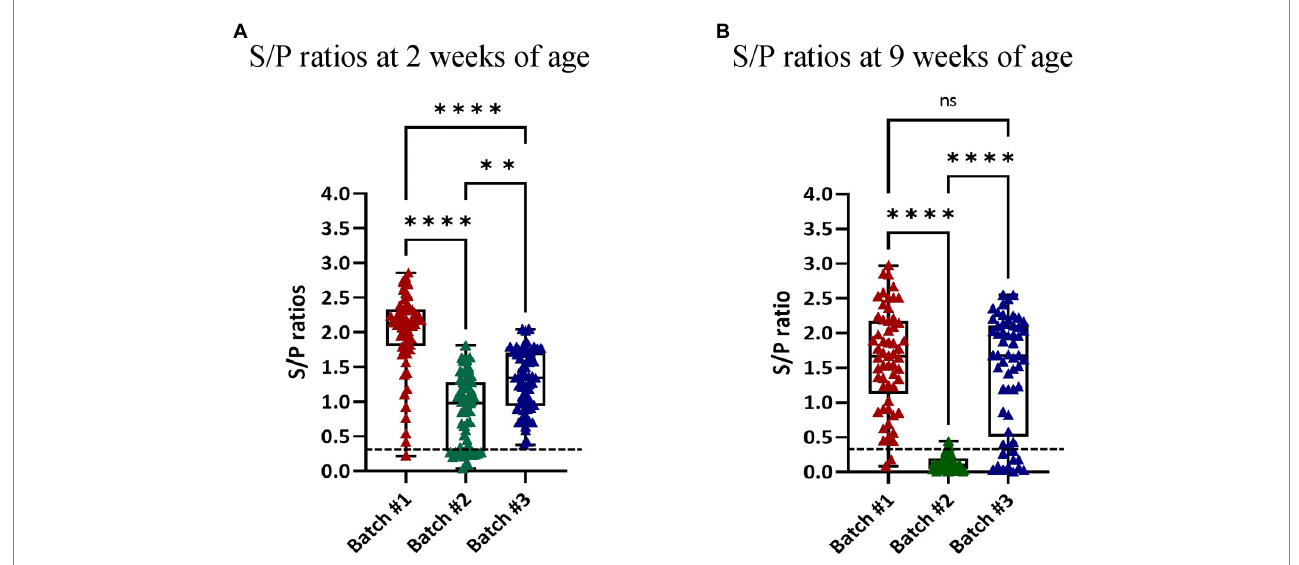
FIGURE 5 S/P ratios of the piglets as determined by ELISA. Each dot represents an examined individual. S/P ratio values ≥ 0.4 are considered positive (dotted line). The graphs show the S/P ratio values of the piglets at 2 (A) and 9 (B) weeks of age in each of the examined batches. ns = not significant.